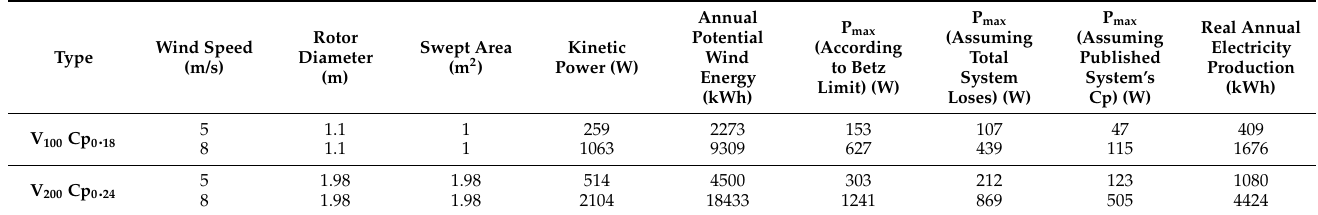
Table 4. Specifications and output of the wind turbines.